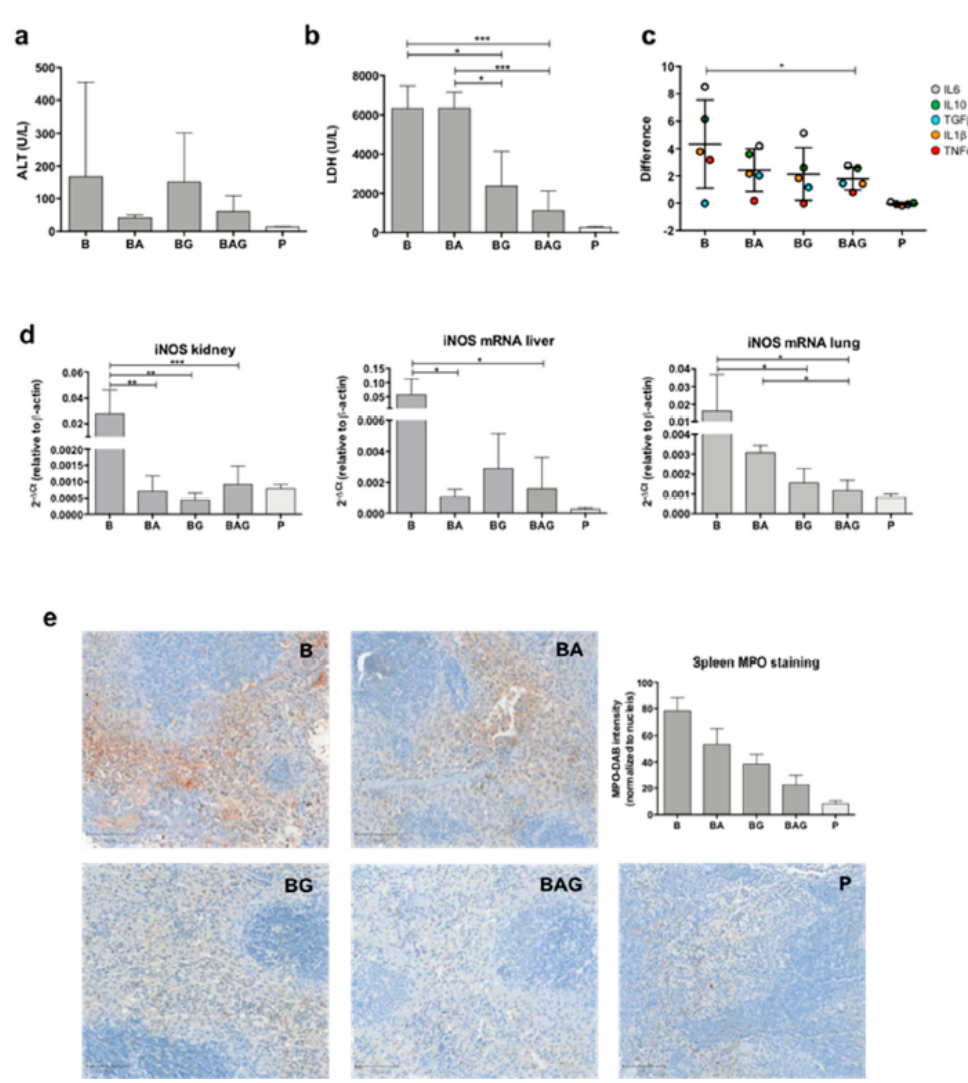
Figure 2. Mouse organ functionality. ( a ) Alanine aminotransferase (ALT) levels (U/L) from all treatment groups and control P mice, grouped according to Table 1. ( b ) Lactate dehydrogenase (LDH) levels (U/L) in the different treatment groups. ( c ) Difference distribution between the control group (dotted line) and treatment groups (i.e., B, BA, BG and BAG) of logarithmic cytokine mean ( ± SD) from all organs analyzed (i.e., liver, kidney and lung). The pro- and anti-inflammatory cytokines analyzed were interleukin-1 β (IL-1 β ) (orange dots), IL-6 (grey dots), IL-10 (green dots), TGF- β 1 (blue dots) and TNF- α (red dots). Data comparison was performed through the two-way ANOVA ( d ) Inducible nitric oxide synthase (iNOS) mRNA expression in the kidney, liver and lung from all treatment group and control P group( e ) Representative images and quantification (as MPO intensity/number of nuclei) of myeloperoxidase staining (brown color) in spleen samples from treated mice. For all analysis septic mice (B = bacteria, septic mice n = 4), septic-treated mice (BA = bacteria + ampicillin, n = 4; BG = bacteria + Gas6, n = 4; BAG = bacteria + ampicillin + Gas6, n = 5) and control mice ( p = PBS, n = 4) were included. Values are represented as average ± SD. * p < 0.05, ** p < 0.01, *** p <